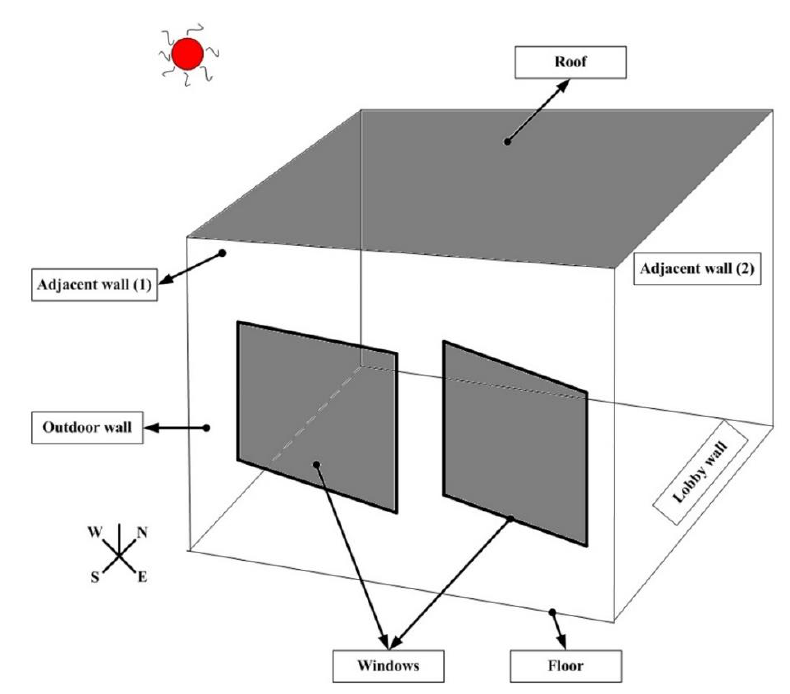
Figure 1. Building elements of the test case